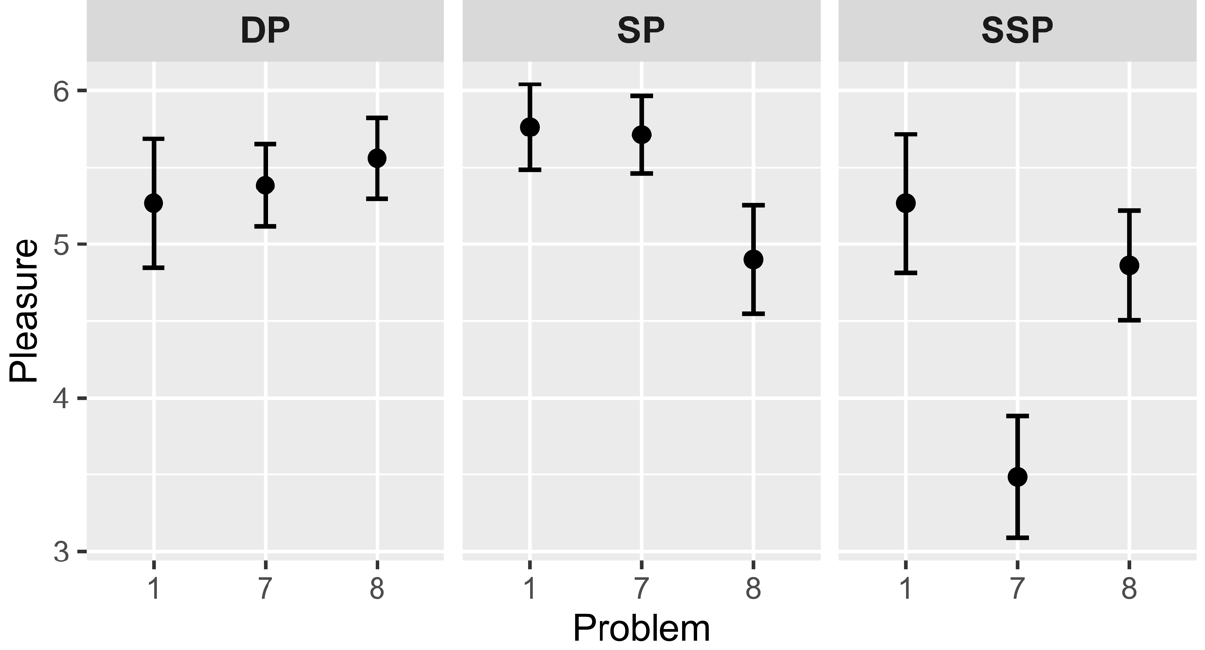
Figure 2. Subjective ratings of pleasure in different groups (1—unpleasure solution, 7—pleasure). Note. Vertical bars denote standard errors. DP—different principle group, SP—same principle group, SSP—same structure and principle group.